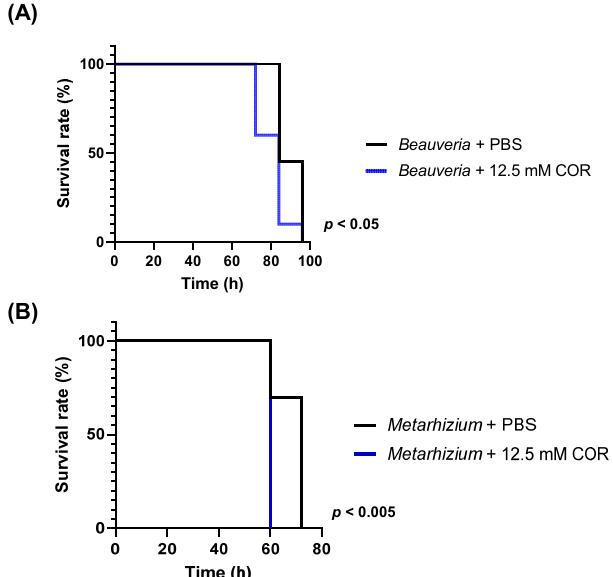
Figure 5. Effect of cordycepin on infection by B. bassiana and M. anisopliae . ( A ) Survival of silkworm larvae injected with 50 µ L of 12.5 mM cordycepin and 25 µ L of 1 × 10 6 conidia/mL of B. bassiana NBRC4848 conidia ( n = 10, triplicate). Results are significantly different using the log-rank test ( p < 0.05, χ 2 = 5.766). ( B ) Survival of silkworm larvae injected with 50 µ L of 12.5 mM cordycepin and 25 µ L of 1 × 10 6 conidia/mL of M. anisopliae NBRC8556 conidia ( n = 10, triplicate). COR indicates cordycepin. Results are significantly different using the log-rank test ( p < 0.005, χ 2 = 10.23).